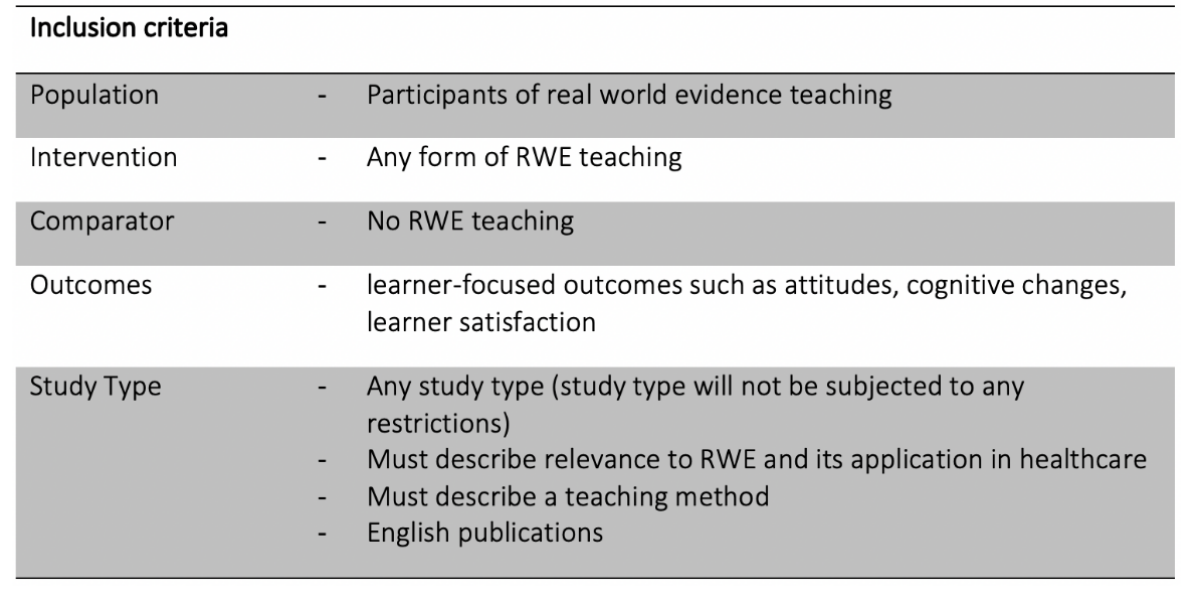
Figure 1. Sample data abstraction